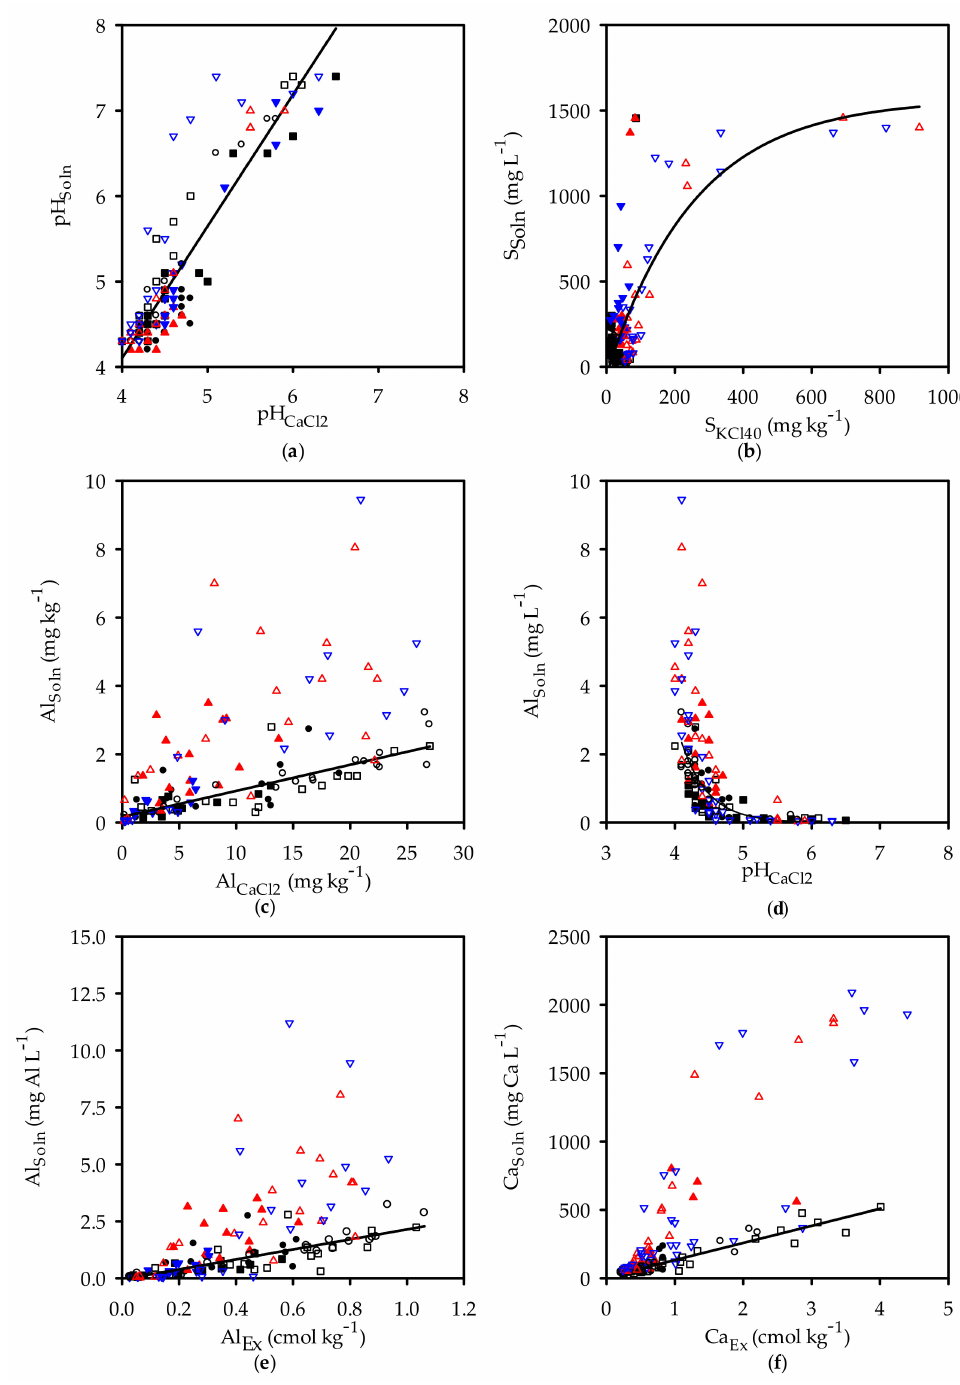
Figure 4. Relationship between soil and solution measurements for ( a ) pH CaCl2 versus pH Soln , ( b ) S KCl ( c ) Al CaCl2 versus Al Act , ( d ) pH CaCl2 versus Al Act , ( e ) Al Ex vs. Al Act , and ( f ) Ca Ex vs. Ca Soln . For the ( a , c , e ) ST experiment treatments C ( ), L2.5 ( (cid:3) ), G2.5 ( (cid:52) ), and L2.5 + G2.5 ( (cid:53) ) ( b , d , f ), and the LT experiment treatment C ( • ), L4.0 ( (cid:4) ), G2.0 ( (cid:78) ), (cid:35) and L4.0 + G2.0 ( (cid:72) ). See Table 1 for regression equations for fitted